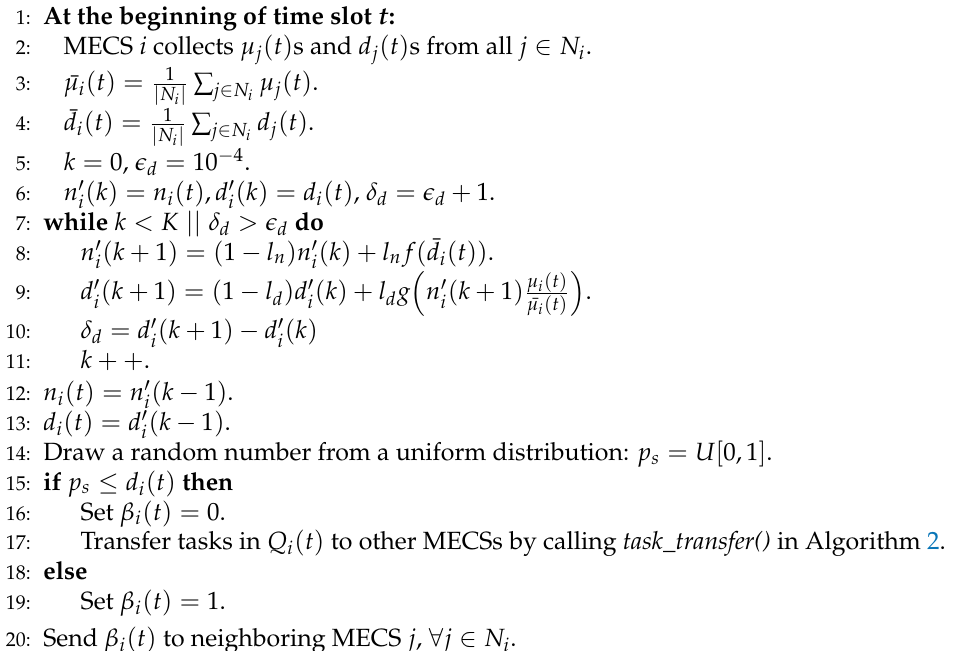
Algorithm 1 Bio-Inspired Sleep Decision